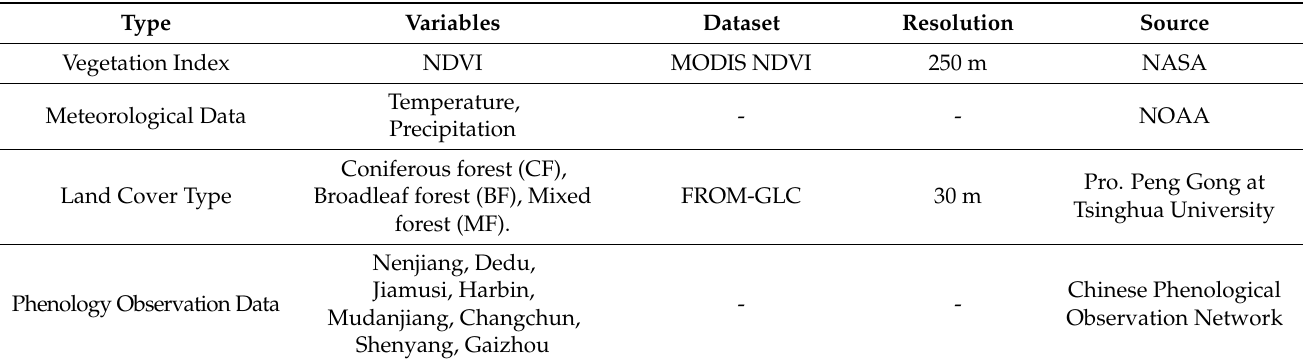
Table 3. Detailed descriptions of research